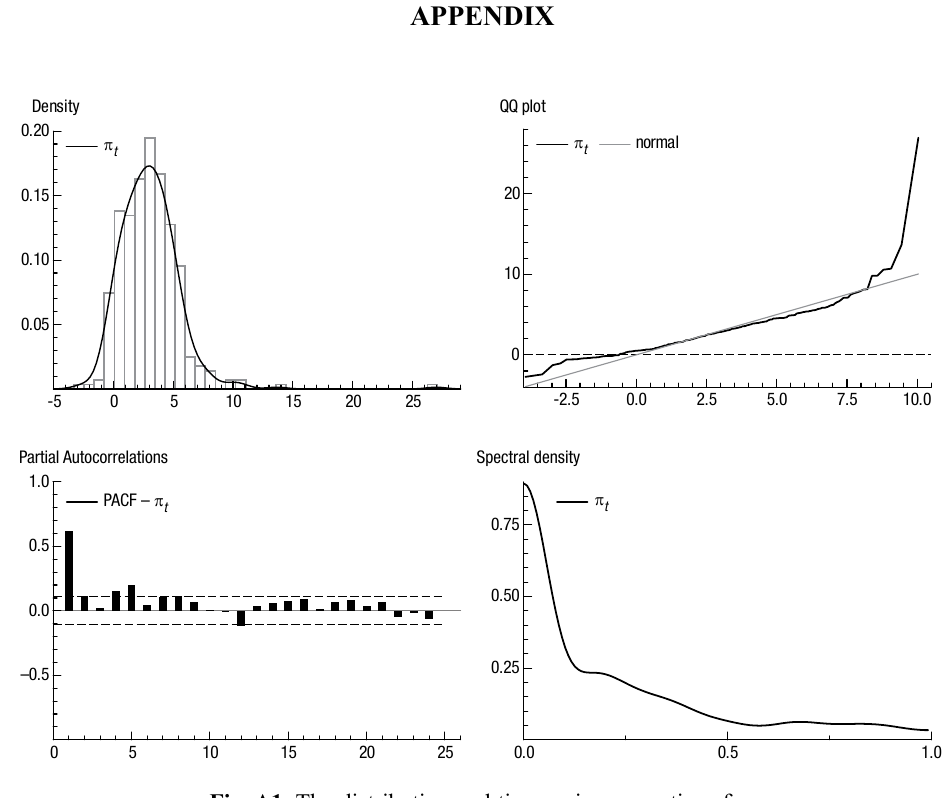
Fig. A1. The distribution and time series properties of p